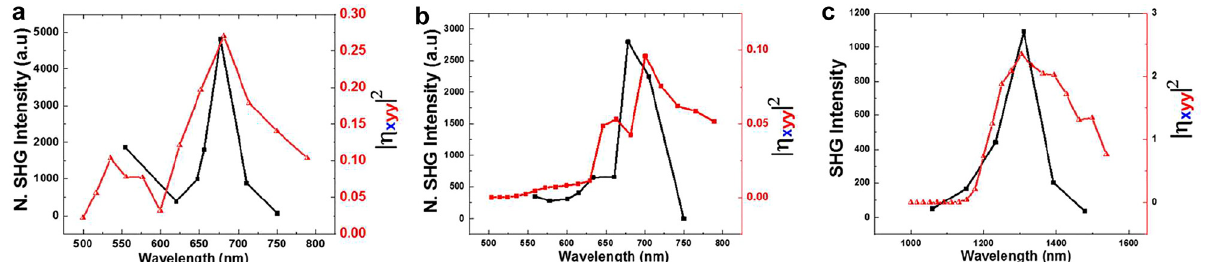
Figure 6: Comparison of SH intensity wavelength dependence between experiment and finite element simulation for (a) SRR Au-DRM. (b) Heptagonal Au-DRM. (c) Triangular Au-DRM. The black dots are experimental data points, while the solid curves are the guide to the eye. The redsolidcurveisfitfortheFEMsimulationdata(redsquaredots).Theincidentexcitationis y -polarizationandtheSHGemissionwasdetected for x -polarization.